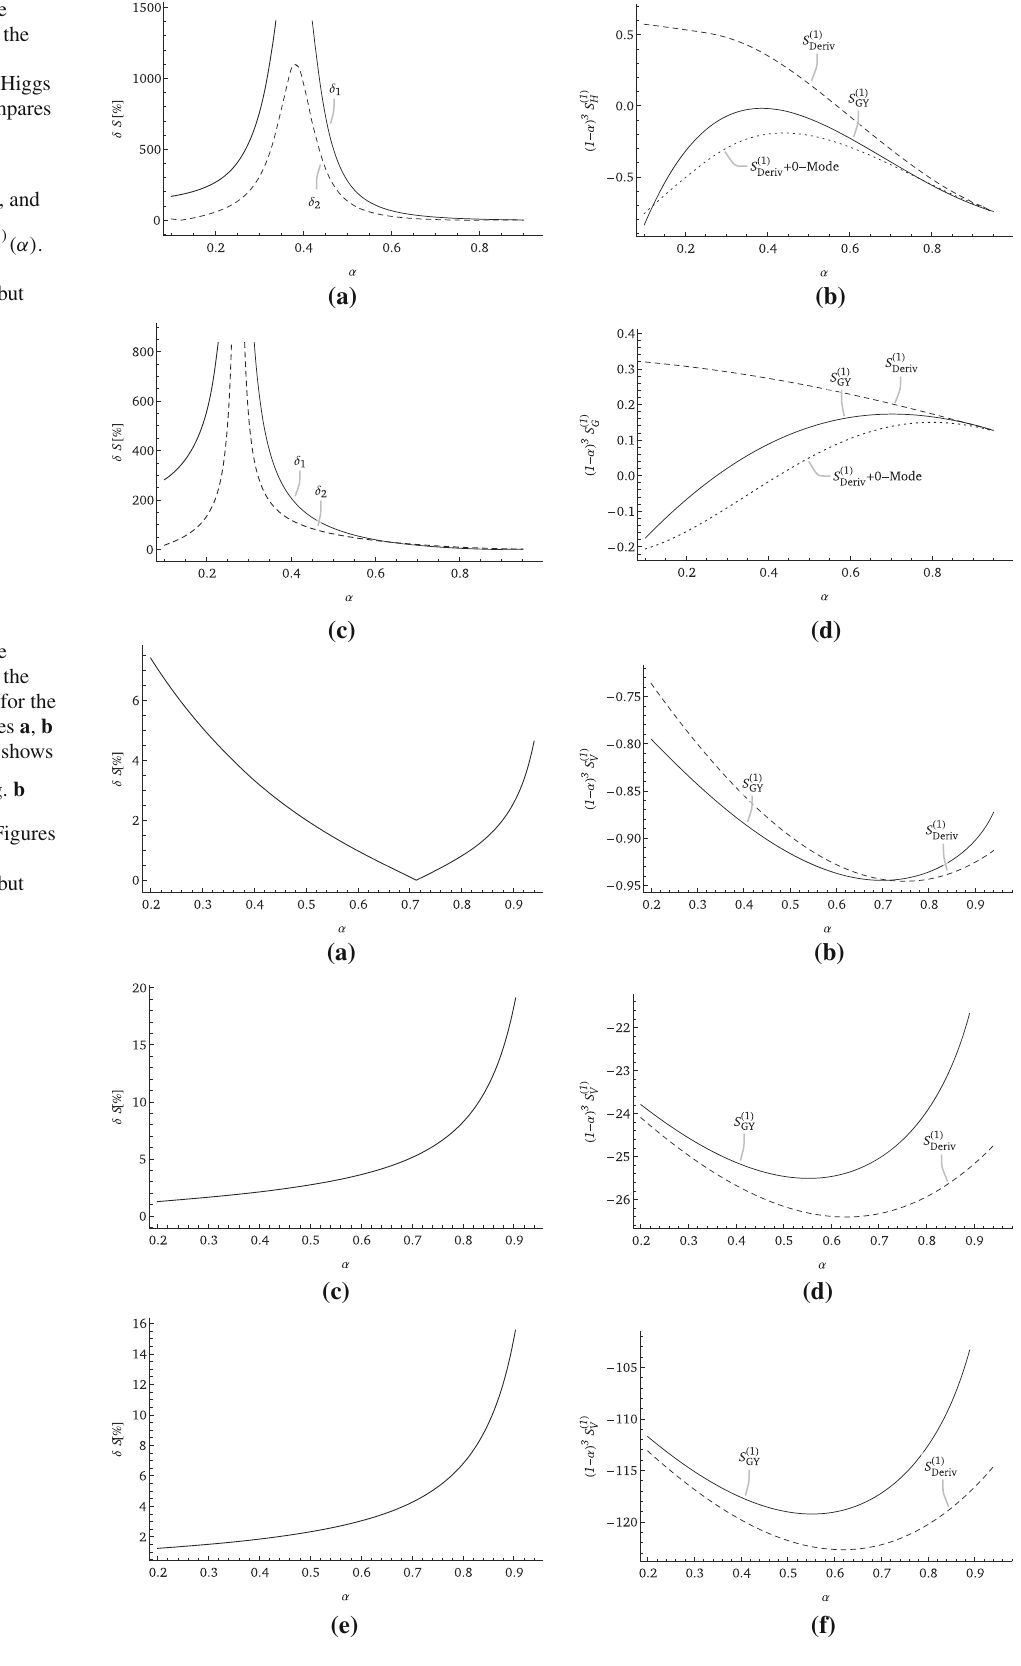
Fig. 2 Comparison of the derivative expansion with the Gelfand–Yaglom method.